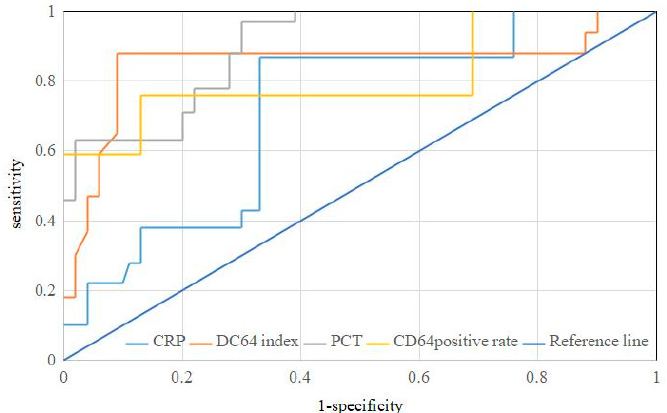
Table 5. Diagnostic efficacy of infection indicators for acute pancreatitis complicated with sepsis.